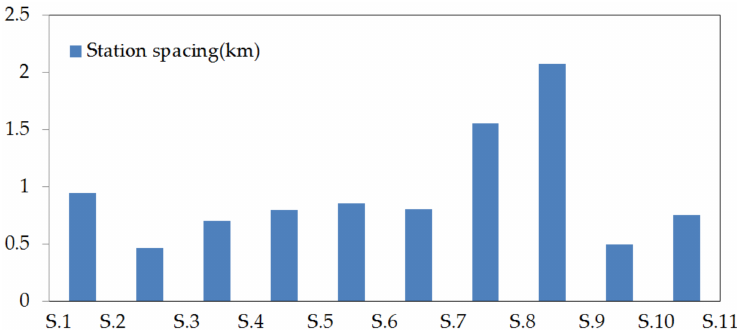
Figure 7. Histogram of station spacings of the tram